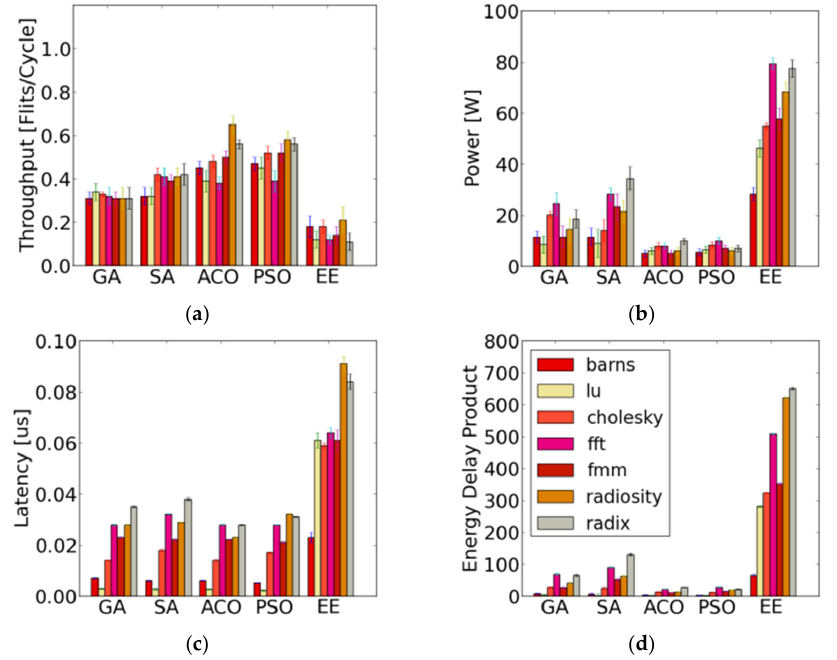
Figure 9. SPLASH-2 [45] benchmarks comparison for 6 × 6 NoC. ( a ) throughput, ( b ) power, ( c ) latency, and ( d ) energy delay product.